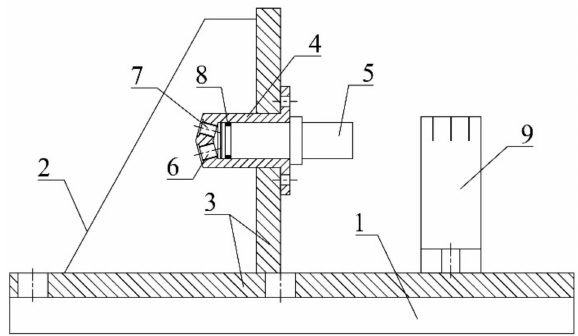
Figure 9. Cross-sectional view of the piston type of measuring device. 1—base, 2—rib plate, 3—bracket, 4—cylinder, 5—piston, 6—cartridgeport, 7—pressuretransducerport, 8—O-rings,